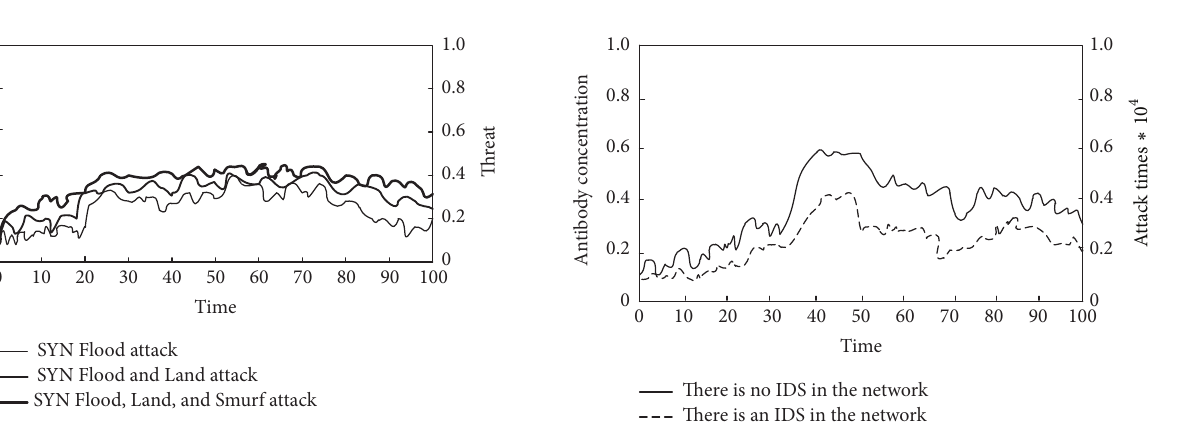
Figure 5: Under conditions with IDS and without IDS, the host 𝑠 2 of antibody concentration and attack times